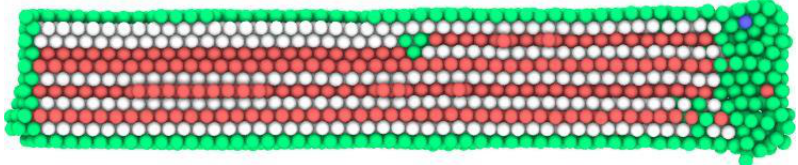
Fig. 23. Cut of the amorphized nanorod by the plane perpendicular to the Y axis, at the time instant 10 ps after the cyclic loading start.  x 0 = 0.5 Å,  =1 THz. Green shows the surface atoms and other structureless ones; white shows the atoms forming the FCC lattice; blue shows the atoms forming the BCC lattice; red shows the atoms forming the FCCP